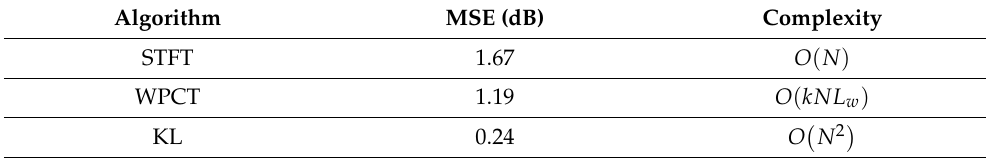
Table 2. Mitigation performance and implementation complexity comparison. JSNR = 30